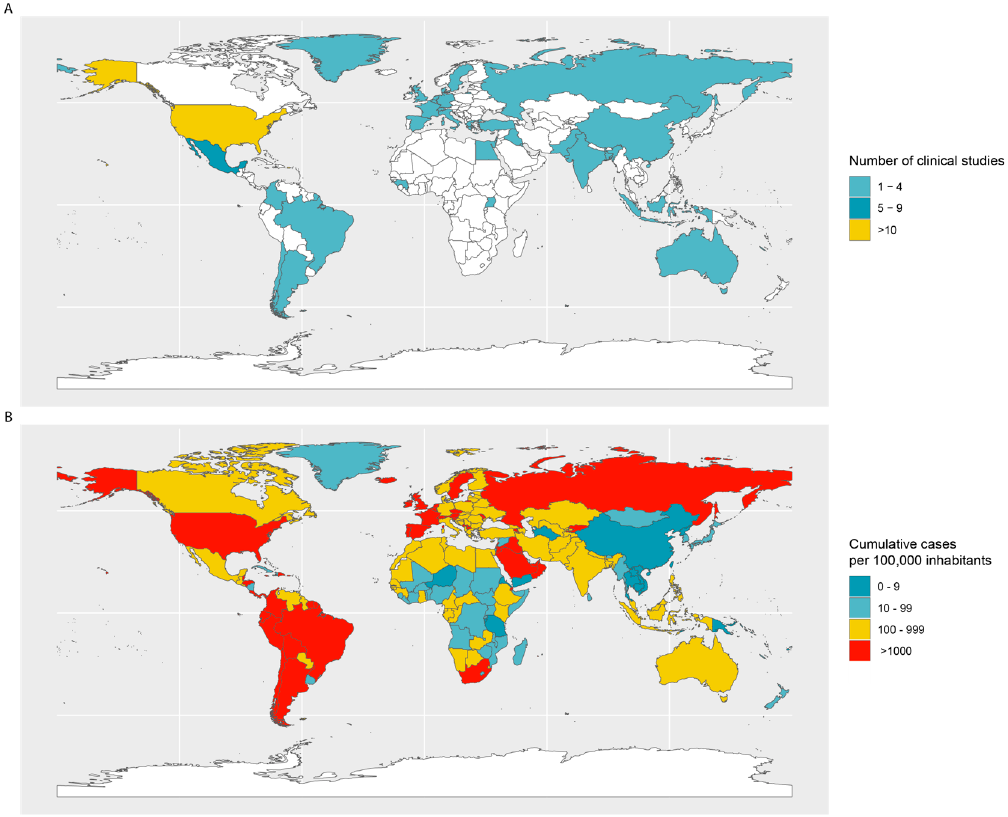
Figure 1. ( A ) Global distribution of the registered clinical trials for convalescent plasma therapy. ( B ) Dispersal of the number of cases per country as of 29 October 2020 (cumulative cases per 100,000).